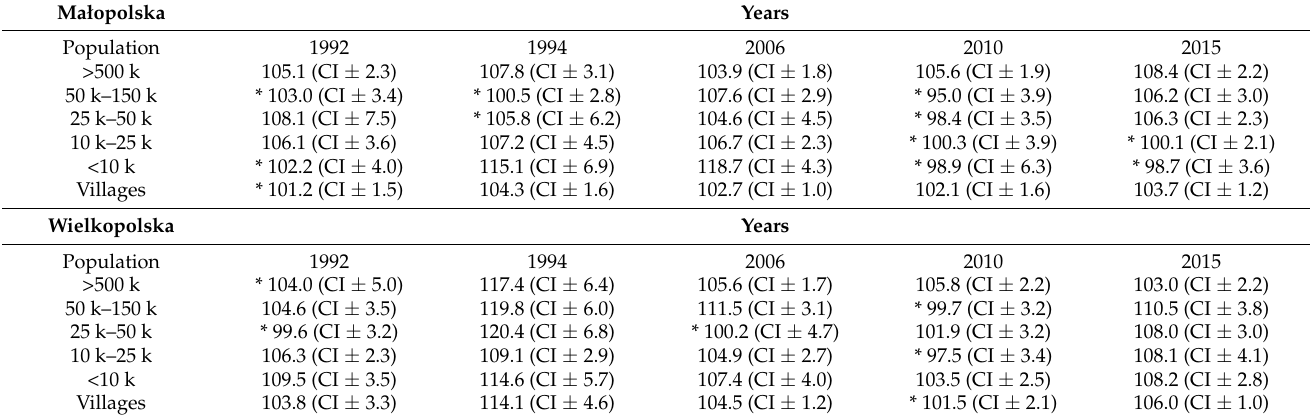
Table 3. Heat-related mortality during the five summer periods calculated as percentage of the expected number of deaths. The period between the first sub-wave and the thirtieth day after the end of the last sub-wave. All causes of death and age groups are included. The 90% confidence intervals are in brackets. Statistically insignificant results are marked with